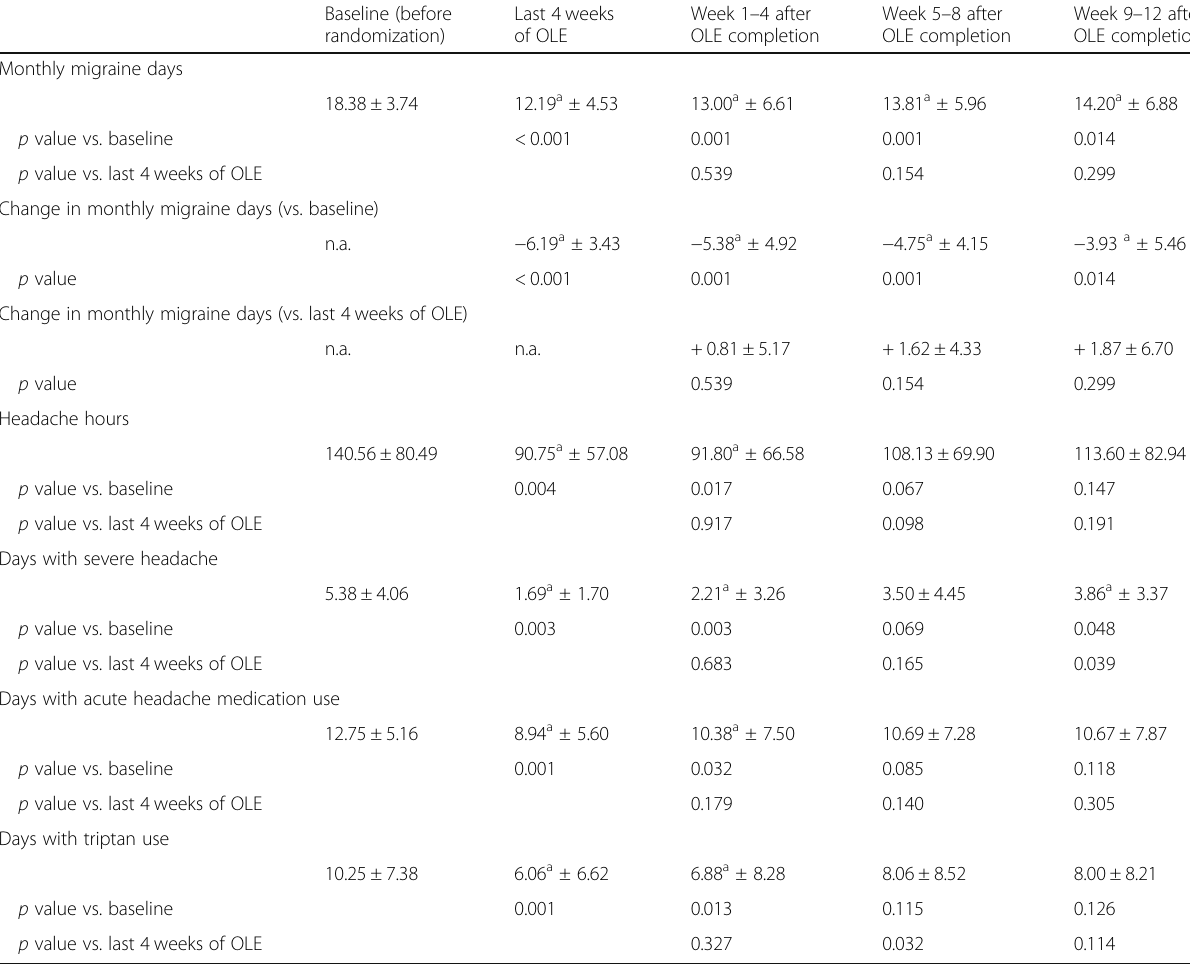
Table 1 Headache characteristics during baseline, the last 4 weeks of open-label extension (OLE) and the observation period of 12 weeks following OLE termination (pooled